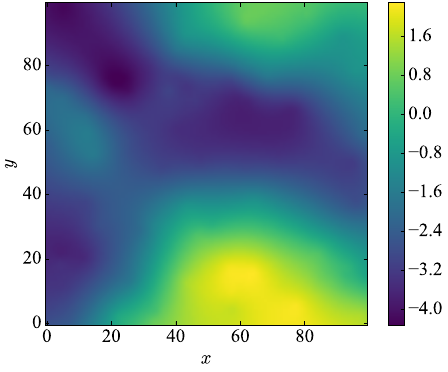
Figure 11. Artificial environmental variables for simulation